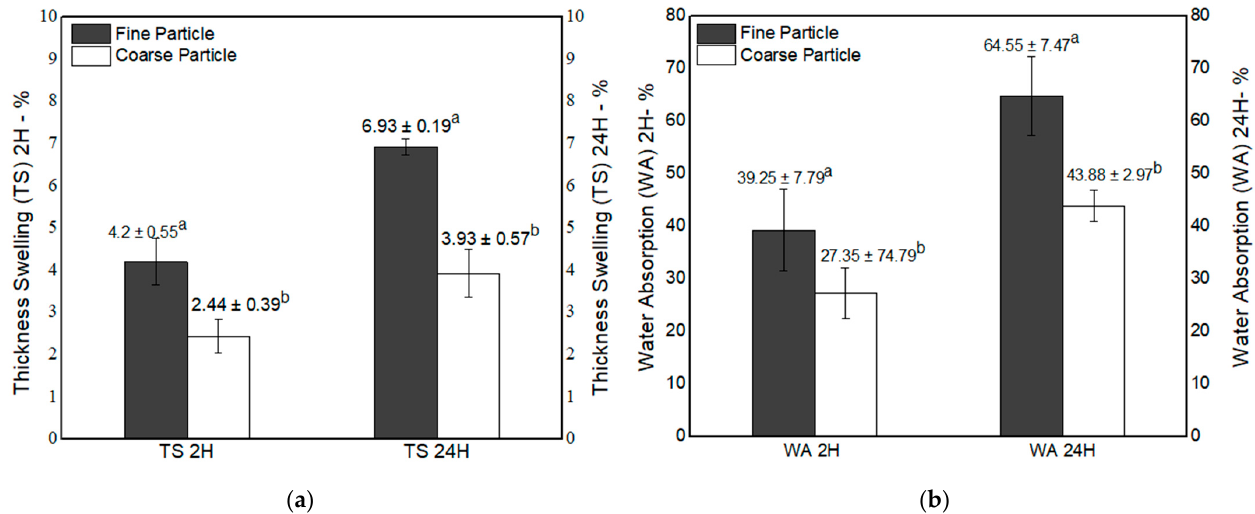
Figure 1. ( a ) Thickness swelling (TS); ( b ) water absorption (WA) of particleboards with different particle sizes. Values followed by different letters are statistically different at p < 0.05.